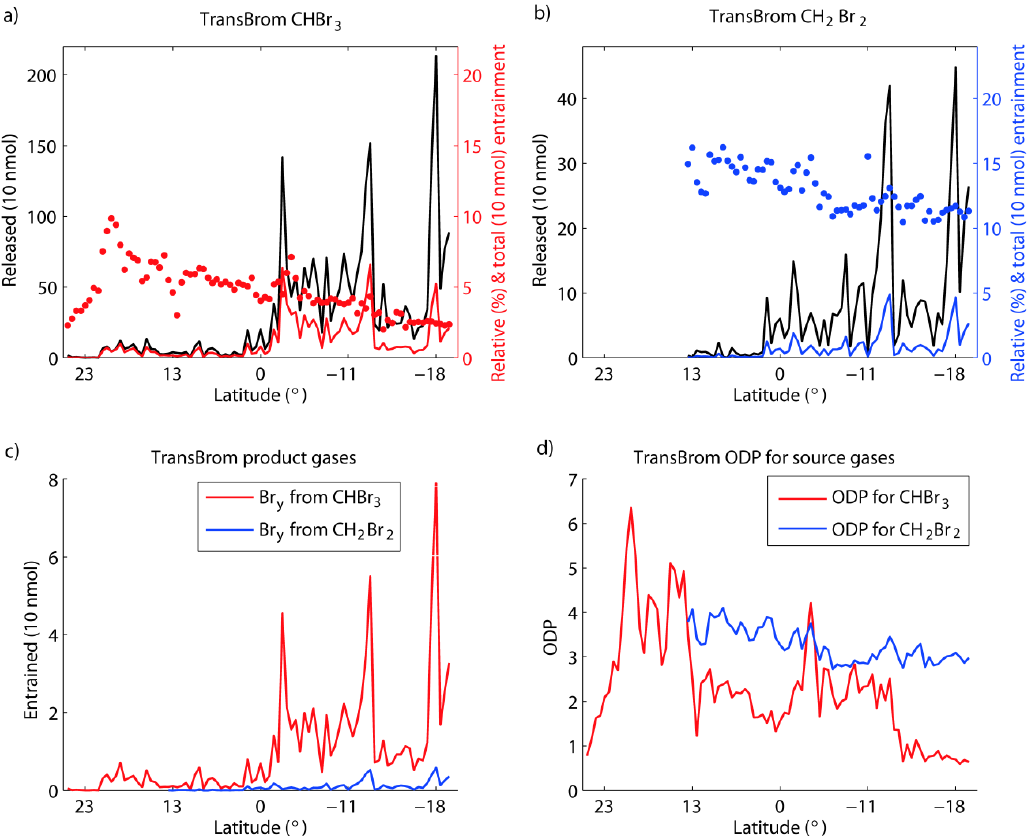
Figure 3. Observed emissions of VSLS for one hour over 500 m 2 (black line), and relative (colored dots) and total (colored line) amount of VSLS entrained above 17km for CHBr 3 (a) and CH 2 Br 2 (b) are shown. PGI is given based on CHBr 3 and CH 2 Br 2 emissions (c) . Ozone depletion potential as a function of emission location is displayed for both VSLS (d) .